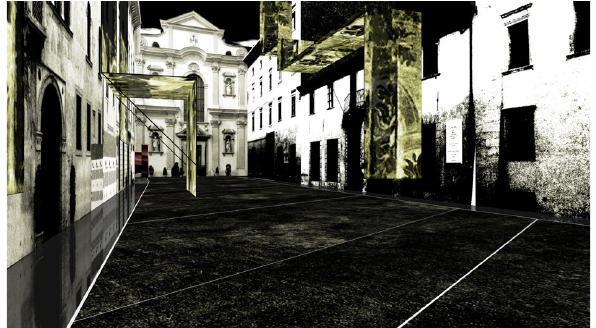
fig. 3 Trento model: the accesses to the rooms fig. 4 Trento model: the night